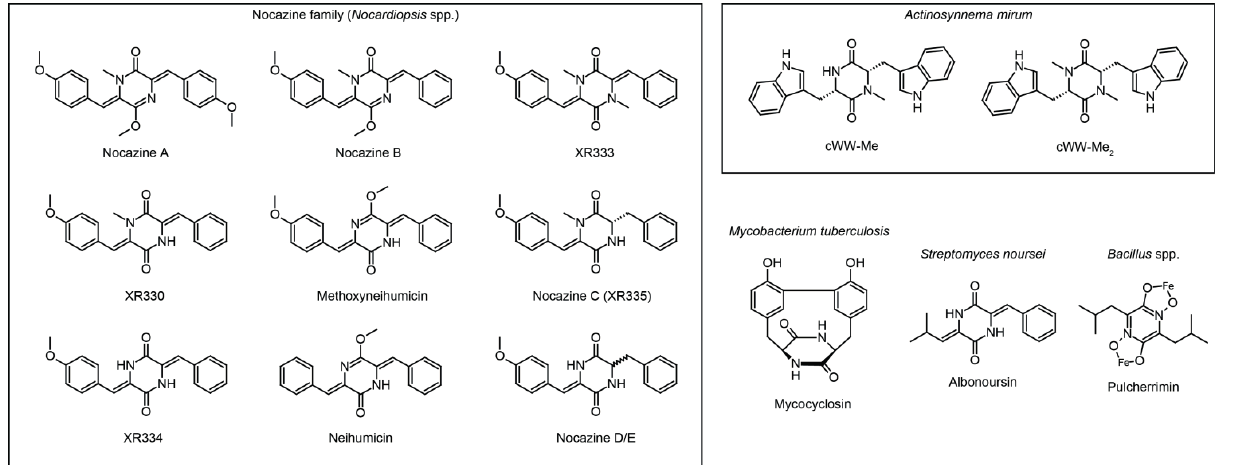
Figure 2. Structures of modified CDPs known to be produced in tRNA-dependent CDPS